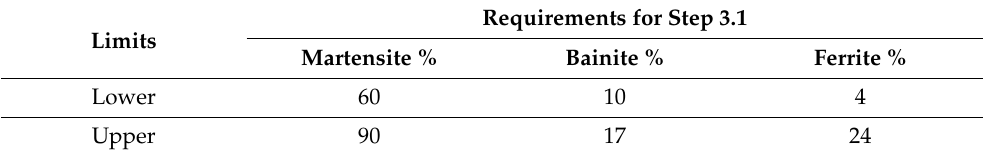
Table 10. Requirements on Microstructure